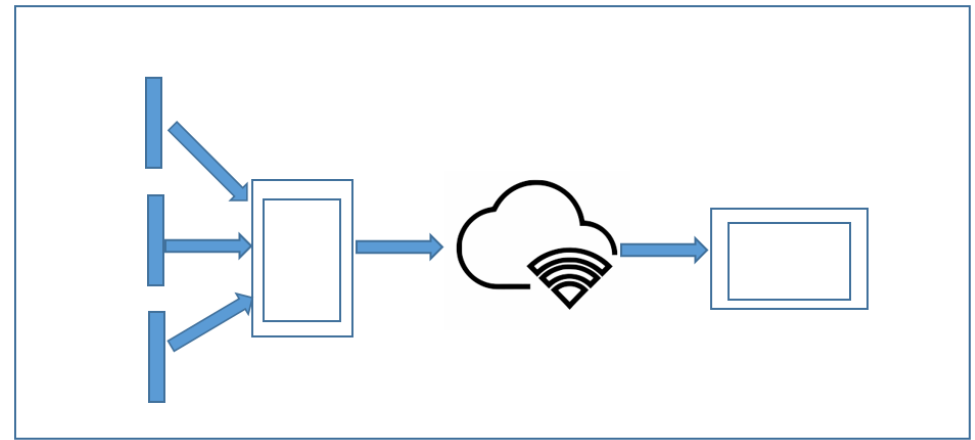
Figure 2. Software Architecture for both-sides feedback.